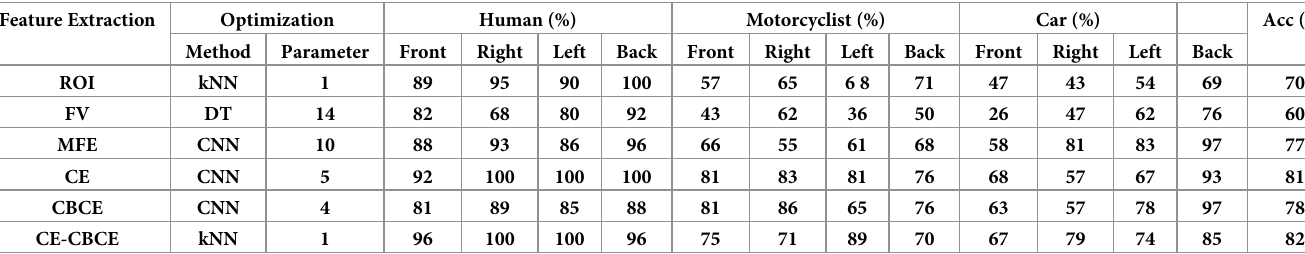
Table 6. Object prediction with pose detection. Feature